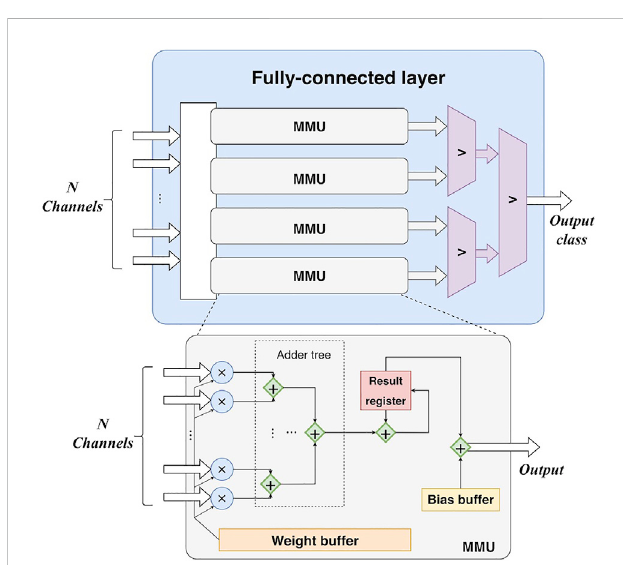
FIGURE 6 The hardware design of the fully-connected layer. MMU: matrix multiplication unit. N -channel input is fed into each MMU in the fully- connected layer. In other words, all MMUs share the same N -channel input and perform calculations in